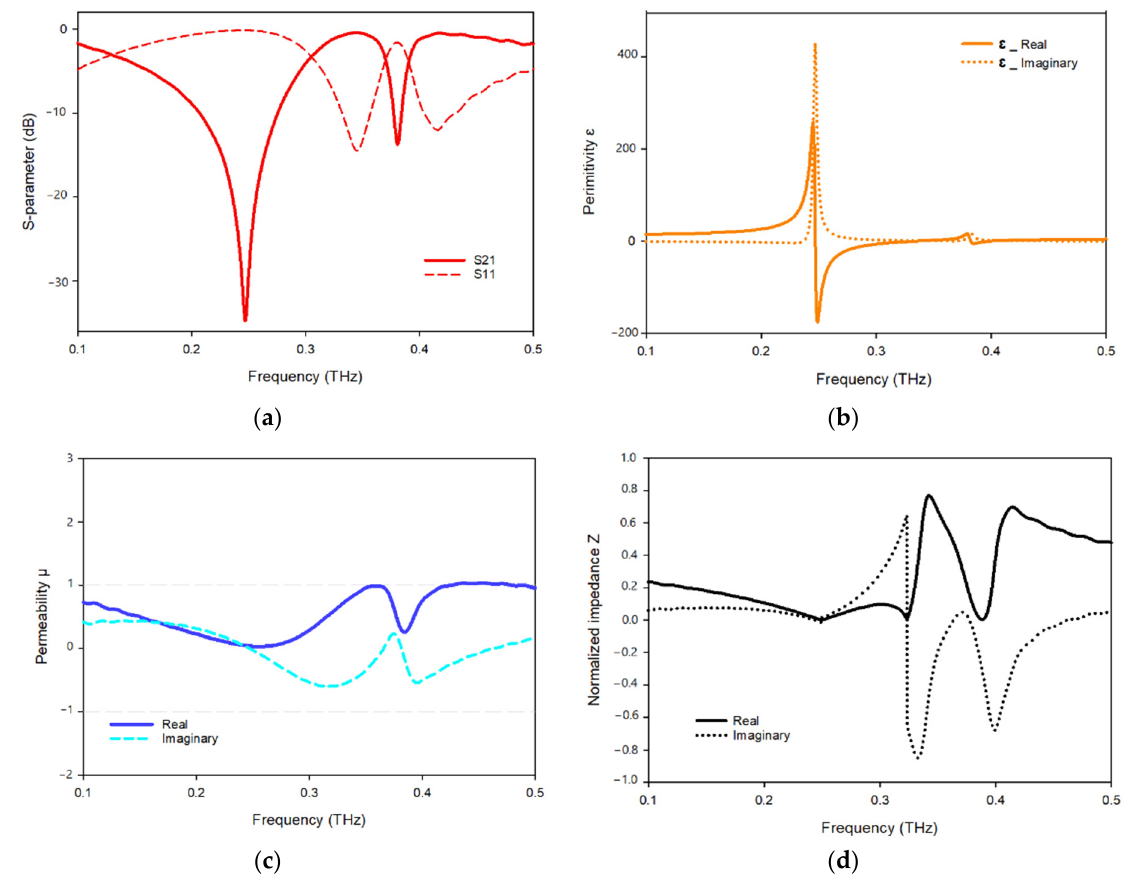
Figure 11. ( a ) S-parameter; ( b ) permittivity; ( c ) permeability; ( d ) normalized impedance.